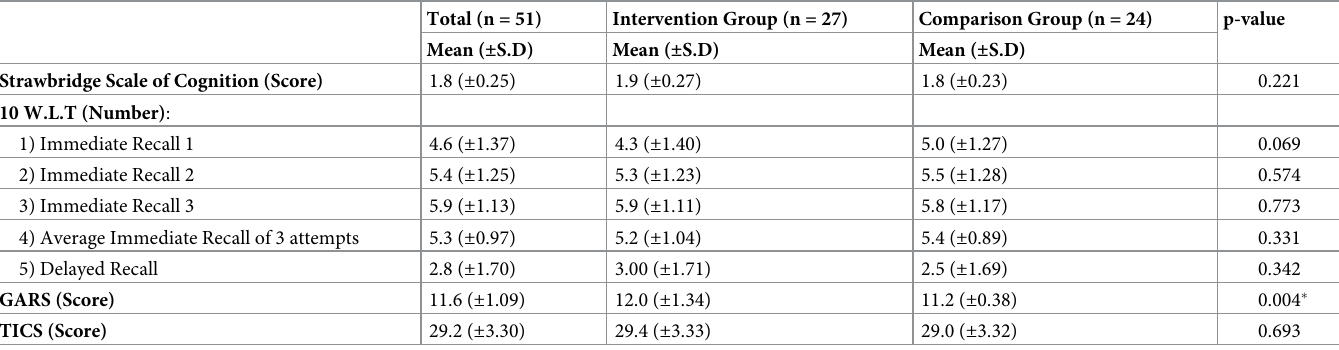
Table 4. Baseline screening cognitive ability and ADL